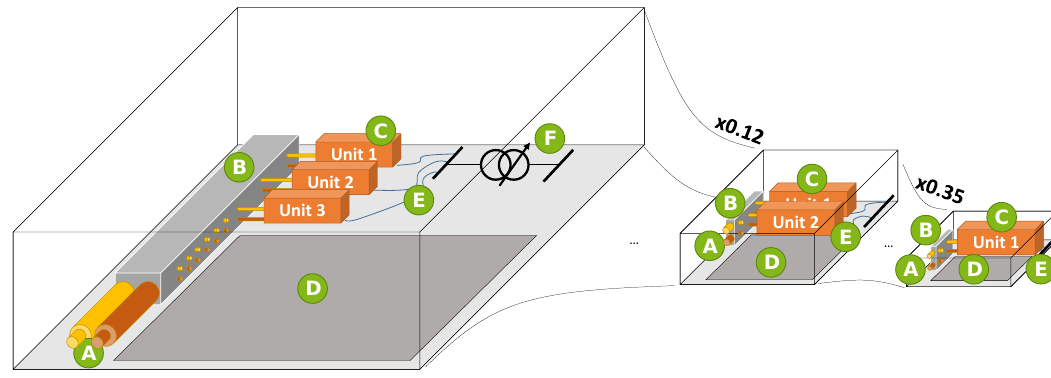
Figure 5. Three examplary configurations as a response to different spatial requirements indicate general scalability and universality of the system